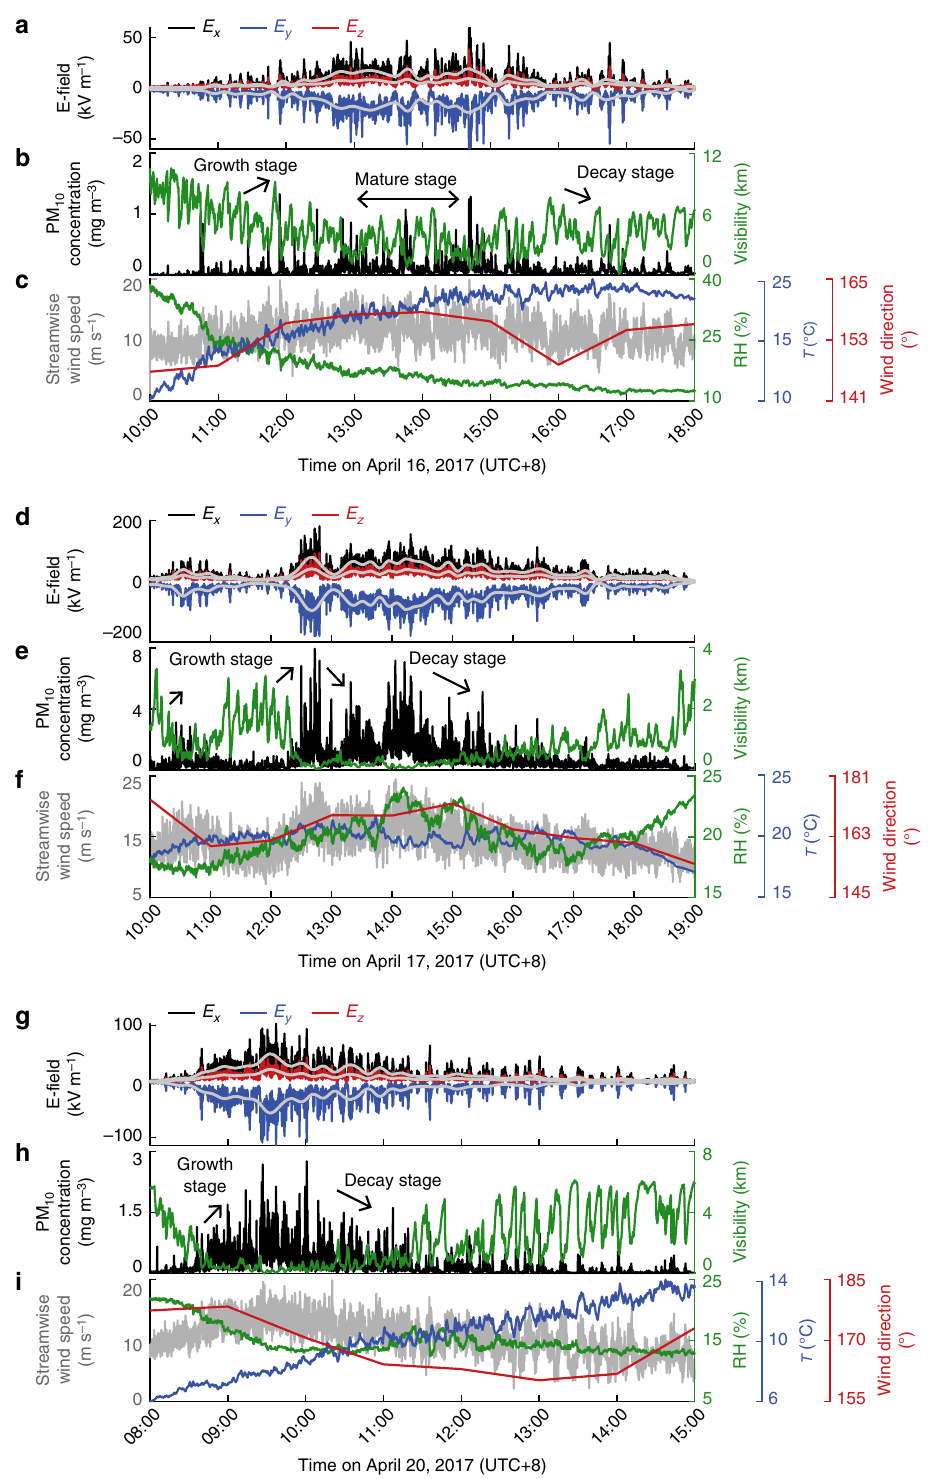
Fig. 2 Examples of the measured data for the three observed dust storms. a – c Time series of the 3D E- fi eld, PM 10 concentration and visibility, as well as streamwise wind speed, wind direction, ambient temperature ( T ), and relative humidity (RH) data for storm #1. Here, E- fi eld components E x , E y , and E z point in the positive direction of the x -, y -, and z -axis, respectively. As an example, the data of the 3D E- fi eld, PM 10 concentration, streamwise wind speed, and wind direction are only shown at measurement point p9. d – f As in a – c but showing the data for storm #2. g – i As in a – c but showing the data for storm #3. Storms #1-#3 occurred on April 16, 17, and 20, 2017 (UTC + 8), respectively. Gray lines in a , d , and g denote the time-varying mean of the E- fi eld over the scales of 2 9 s, which is extracted by the discrete wavelet transform method (see